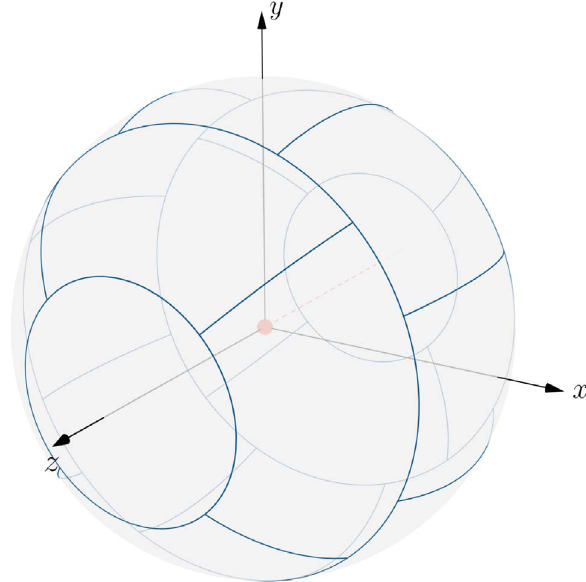
Figure 3. Partitioning of sphere into 18 sections with equal surface area (ES 18